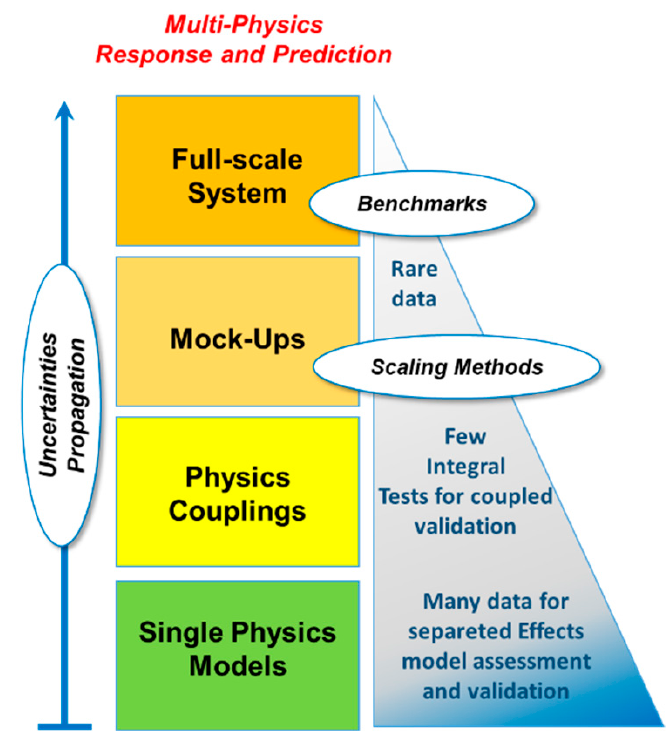
Figure 1. V&V approach for full system response